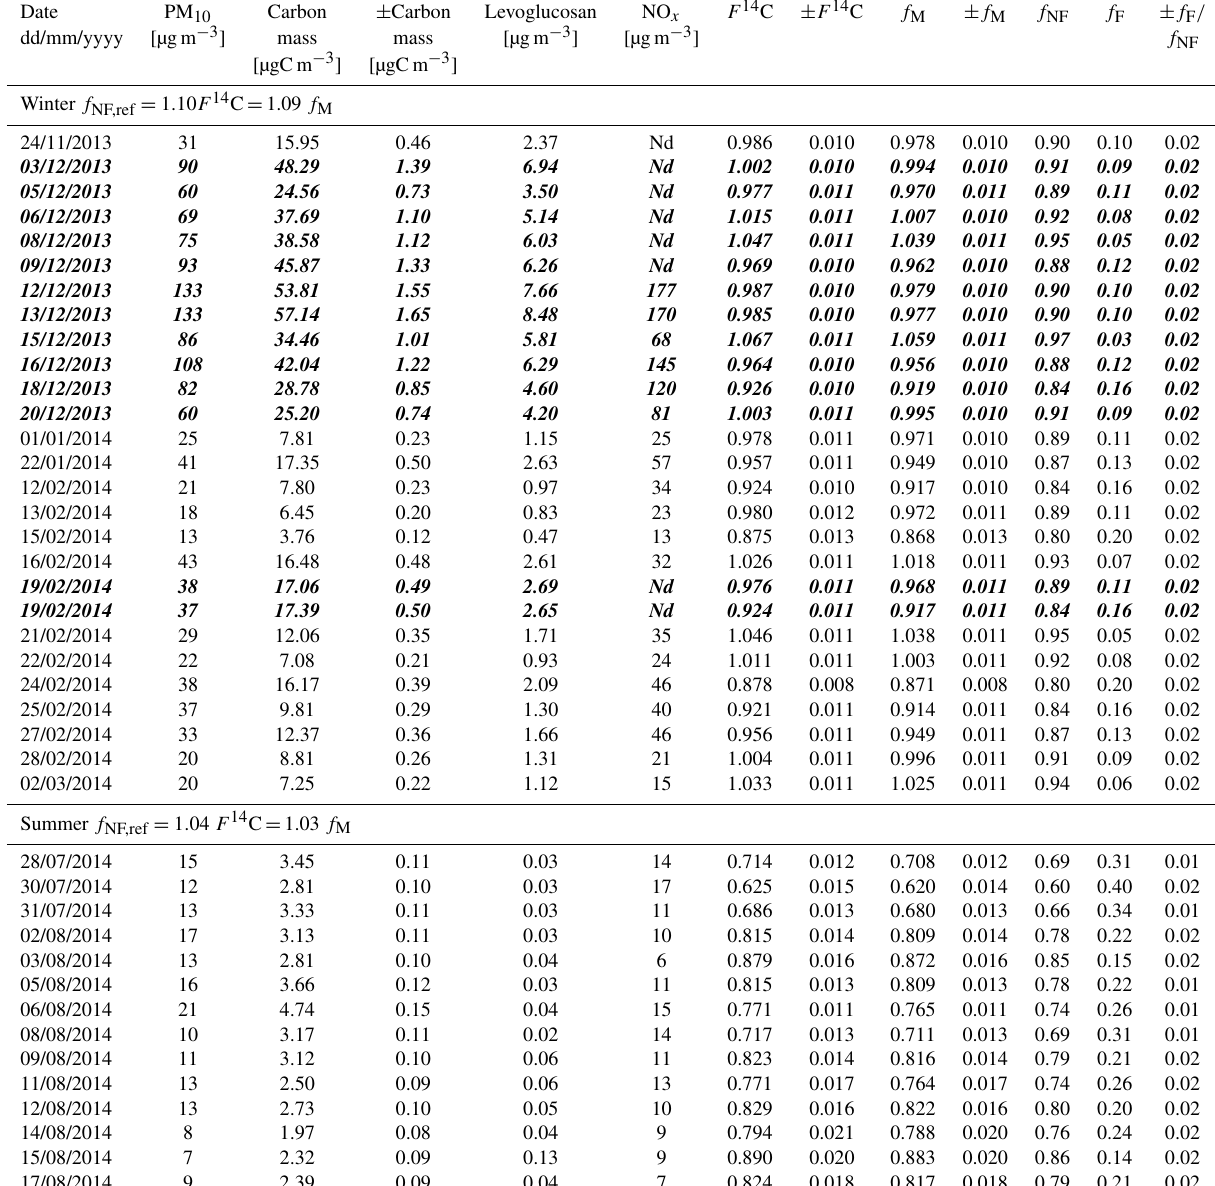
Table 3. Results of analysis of Passy samples. PM 10 is determined by TEOM-FDMS; days with a PM 10 concentration higher than 50µgm − 3 (winter smog) are reported in bold italics (19 February 2014 is sampled with two filters and the sum is greater than 50µgm − 3 ) . Levoglucosan and NO x concentrations: see text. Carbon concentration is determined using the GIS quantification and is expressed with its confidence interval. Each radiocarbon value (expressed in F 14 C and f M ) is based on duplicate measurements: here the weighted mean and its weighted error (2 σ , i.e., 95% confidence interval) are presented. For winter, it is considered that all the non-fossil carbon originates from biomass burning (i.e., f NF,ref = F 14 C bb ) , whereas all the non-fossil carbon during summer is assumed to originate from biogenic emissions (i.e., f NF,ref = F 14 C bio ) . The reference values ( f NF,ref ) for winter and summer are expressed in F 14 C and f M . Fossil and non-fossil fractions ( f F and f NF ) are determined by the radiocarbon measurements (see Eq.